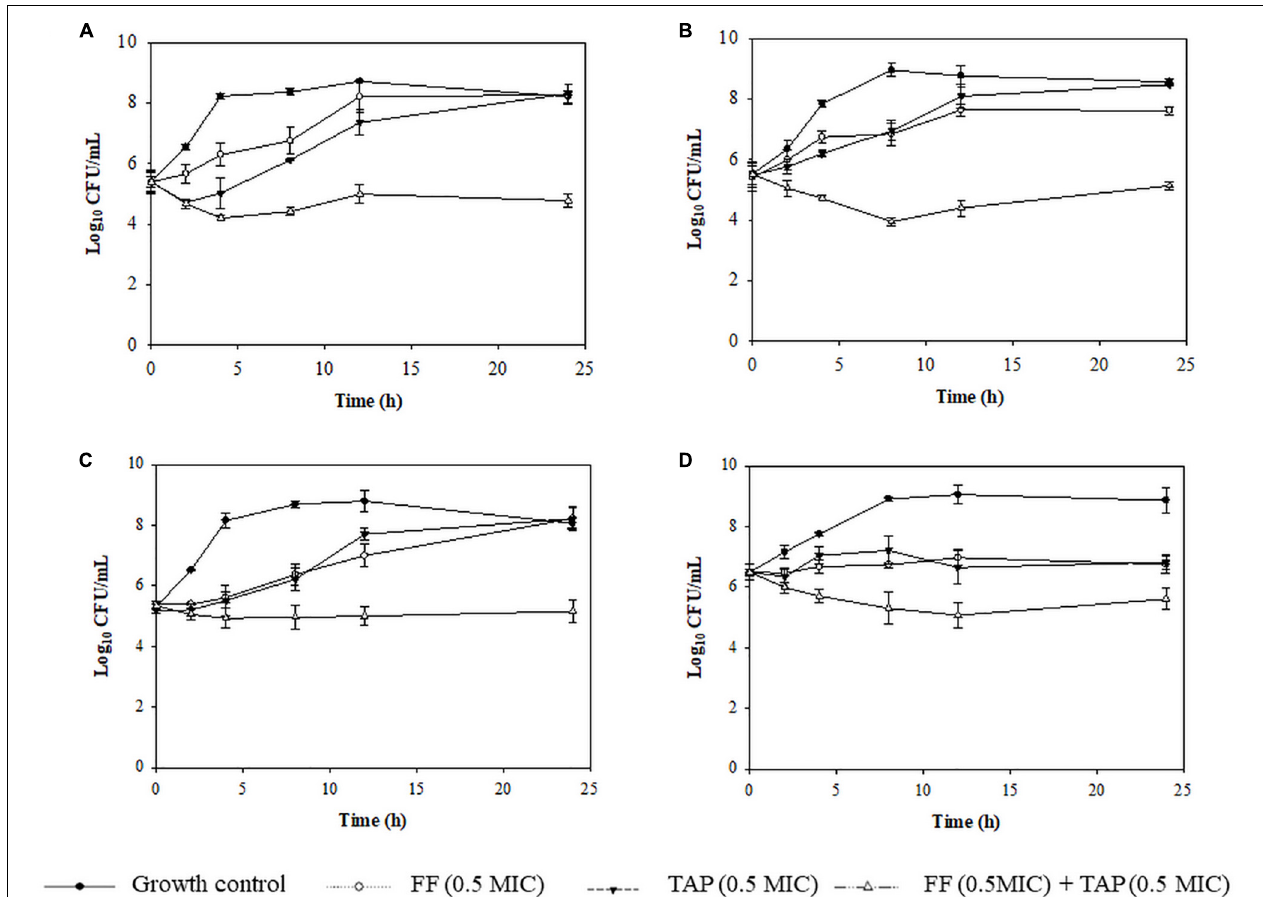
FIGURE 3 | Time-kill assay showing the killing kinetics of FF, TAP alone and in combination against 4 isolates of susceptible P. multocida (A) No. 1 (FICI = 0.38), (B) No. 21 (FICI = 0.53), (C) No. 25 (FICI = 0.75), and (D) No.36 (FICI = 1) which serves as the negative control. Refer to Table 3 for strain details. Results show the mean ± the standard error of the mean (SEM) from three independent